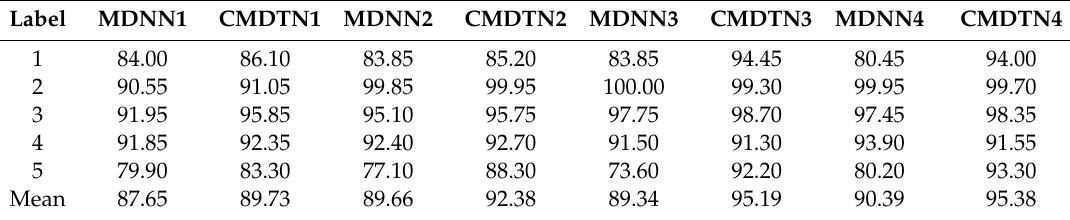
Table 10. The accuracy of DNNs and DTNs when transferring from structurally-complete model to missing data model.